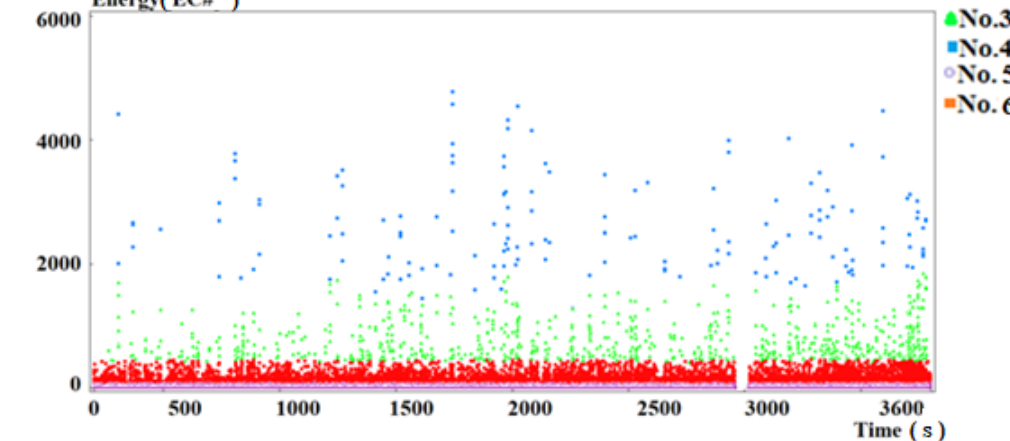
Figure 21. Energy versus time for the third measurement period—March 2017.